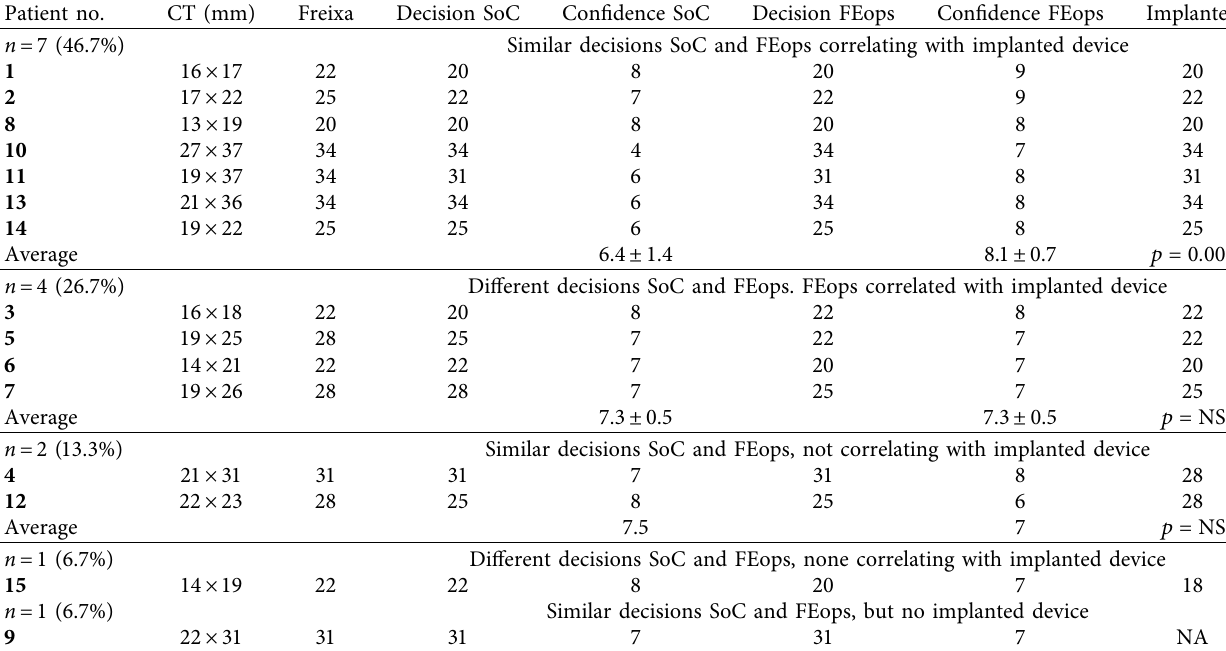
Table 2: Clinical impact in preprocedural